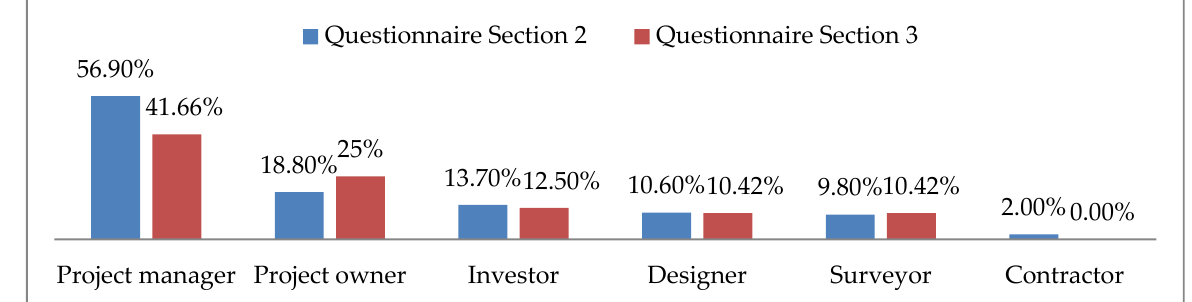
Figure 5. Processed results of Section 1 of the questionnaire. The question “Identification of involvement of experts in the construction process”.